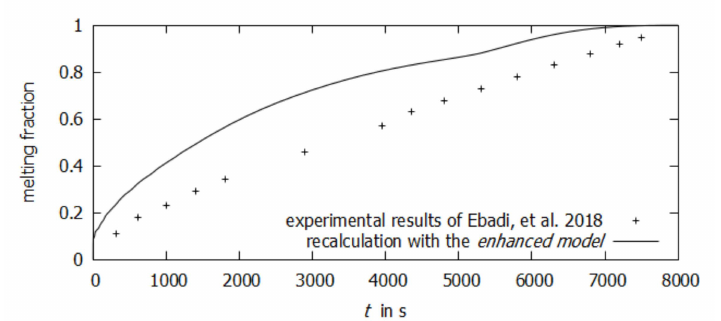
Figure 4. Melting fraction of the enhanced model compared to the experimental results of Ebadi, et al. 2018